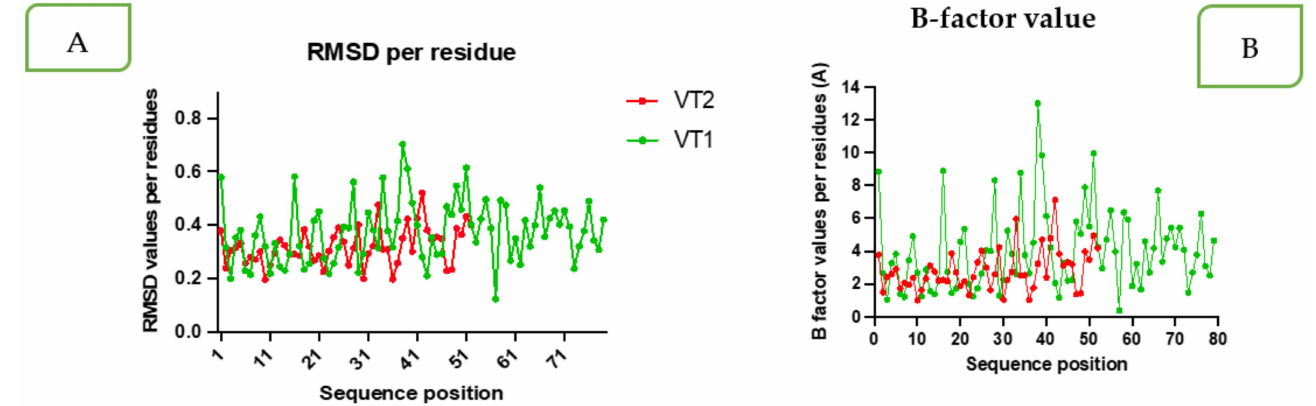
Figure 6. RMSD per residue ( A ) and B-factor value ( B ) per amino acid showing more flexible residues with the sharp peak (red for VT2 and green for VT1).